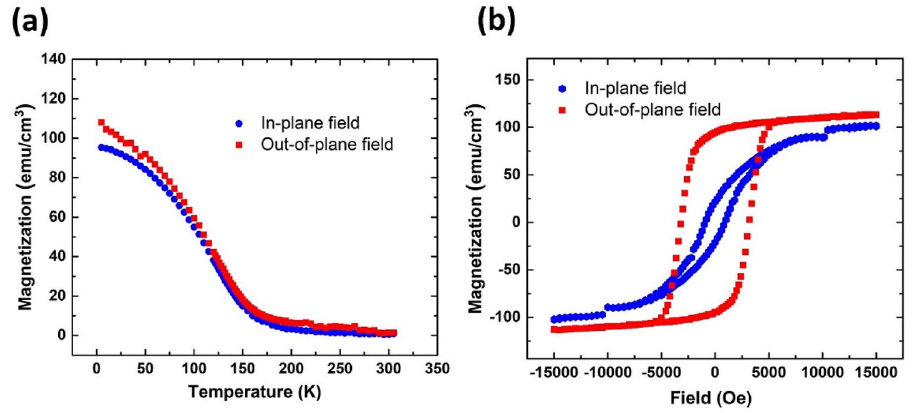
Figure 2. ( a ) Temperature-dependent magnetization ( M – T ) of a 35-nm-thick PdNi film at 10,000 Oe. ( b ) Magnetic field-dependent magnetization of the 35-nm-thick PdNi film at 4.2